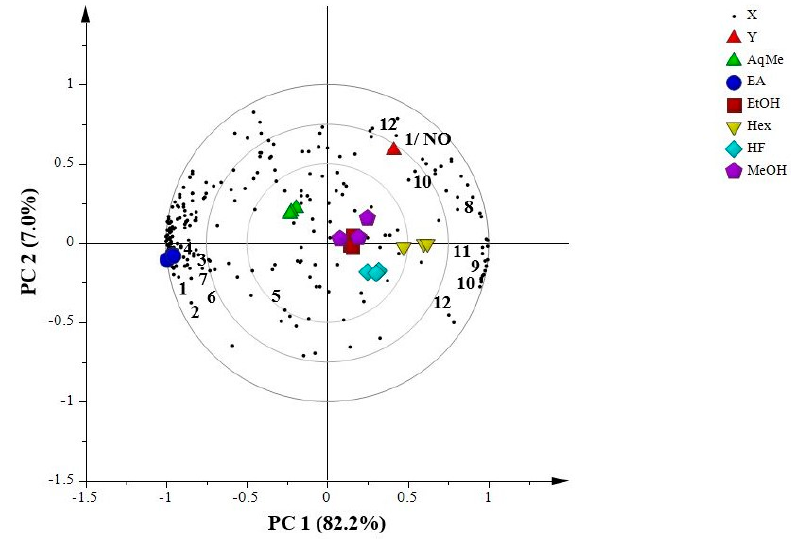
Figure 4. The biplot demonstrates the correlation between extracts and fractions of P. cubeba L. at concentration 62.5 µg/mL with anti-inflammatory activity on nitrite oxide (NO) production. MeOH: methanol extract; EtOH: ethanol extract; Hex: hexane extract; HF: hexane fraction; EA: ethyl